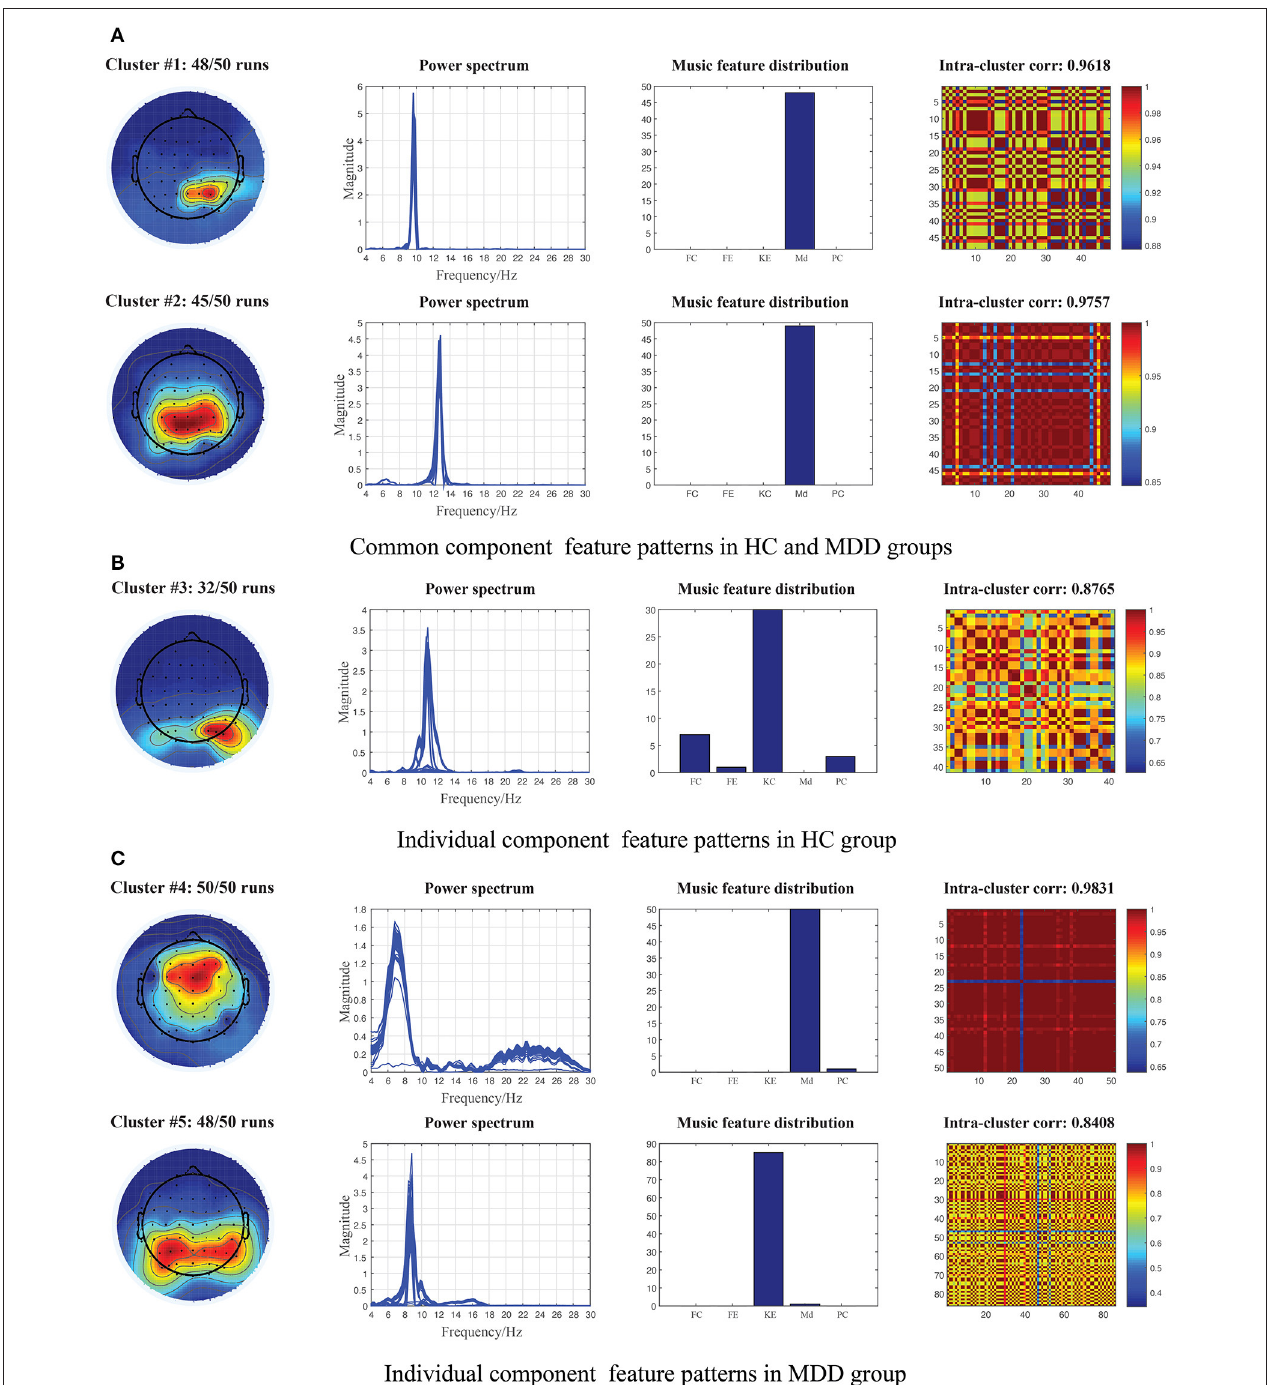
FIGURE 2 | Illustration of the extracted component patterns (from left to right column: mean topography, overall power spectrum, music feature distribution and intra-cluster correlation maps) from HC and MDD EEG data via 50 runs of constrained tensor factorization method, and the parallel temporal component was significantly correlated with at least one of the musical features. (A) Common component patterns clustered from the shared components of 50 runs between HC and MDD data. (B) Individual component patterns clustered from the individual components of 50 runs in HC data. (C) Individual component patterns clustered from the individual components of 50 runs in MDD data. Md, Mode; KE, Key Clarity; FC, Fluctuation Centroid; FE, Fluctuation entropy; PC, Pulse Clarity.